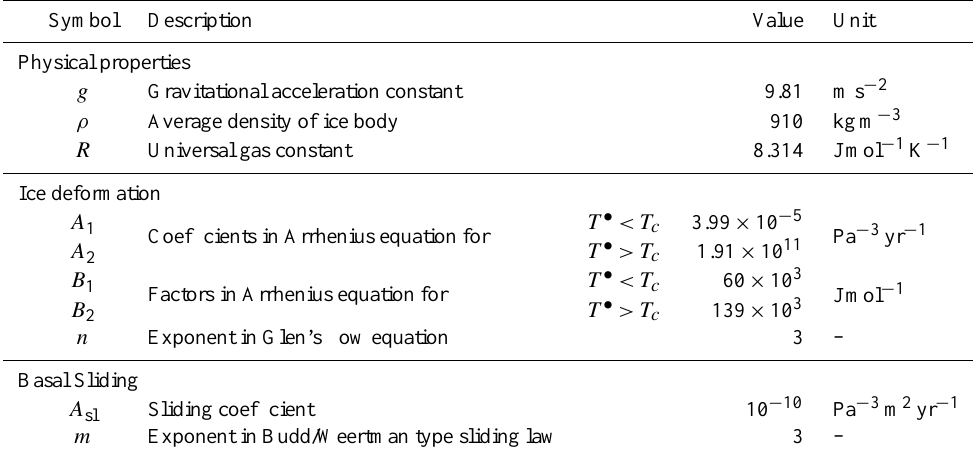
Table 1. Parameter